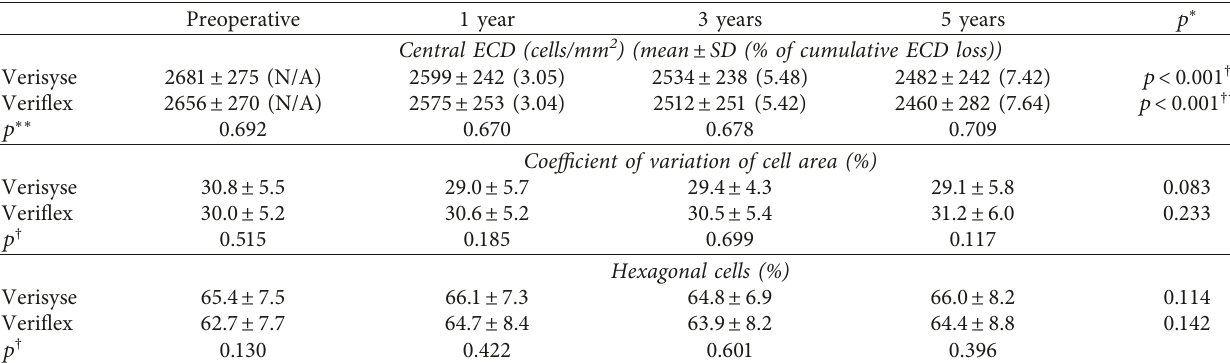
Table 6: Endothelial changes over the course of the study.